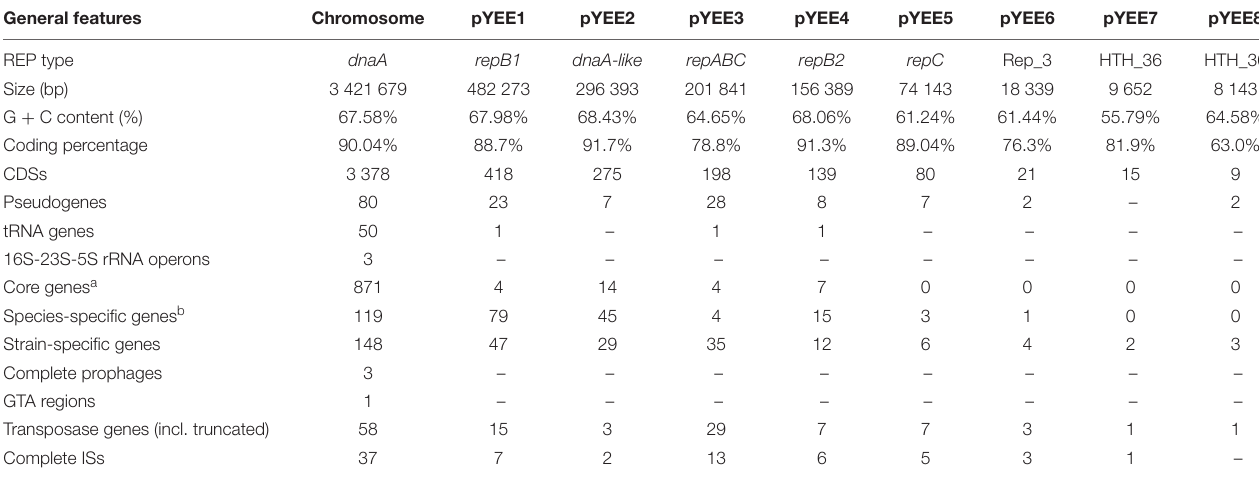
TABLE 1 | General features of the Paracoccus yeei CCUG 32053